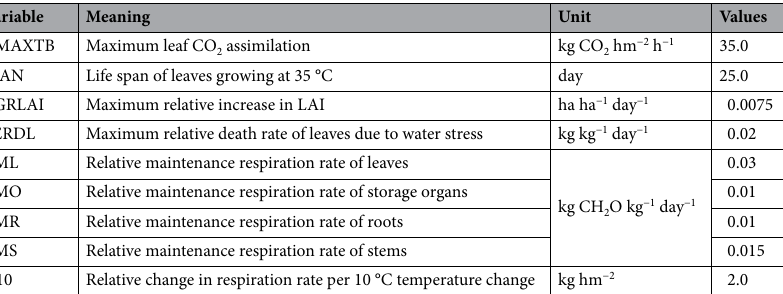
Table 4. The crop parameters of WOFOST model in simulating potential yield of highland barley in the Qinghai-Tibet Plateau.